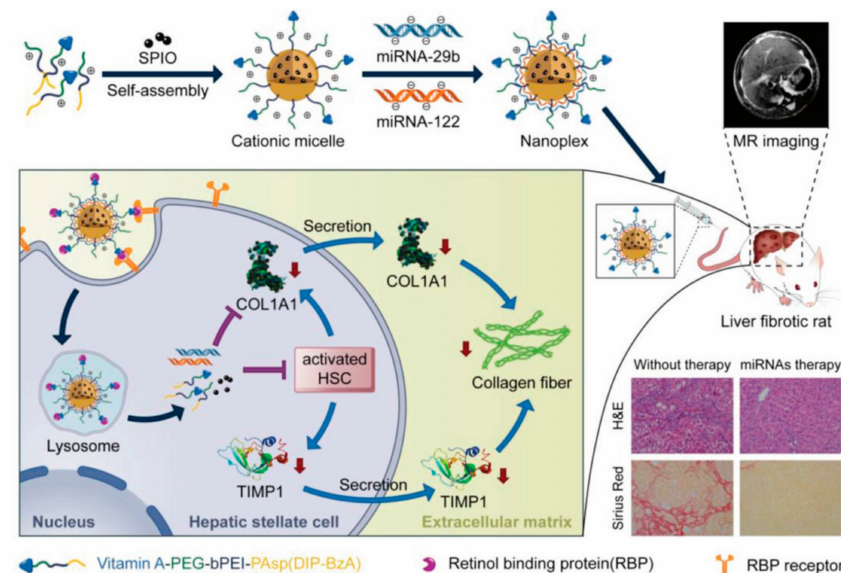
Figure 5. Vitamin A–decorated pH-sensitive and SPIO-loaded nanocomplex T-PBP@miRNA / SPIO (T-miRNA / S) for miRNA targeting delivery in the therapy of liver fibrosis. Expression of liver fibrosis-related genes for alleviating liver fibrosis were synergistically downregulated. The red arrows indicate the reduction of COL1A1, TIMP1, and collagen fiber. Abbreviations: COL1A1, collagen type I alpha 1 protein; TIMP1, tissue inhibitor of metalloproteinase 1; SPIO, superparamagnetic iron